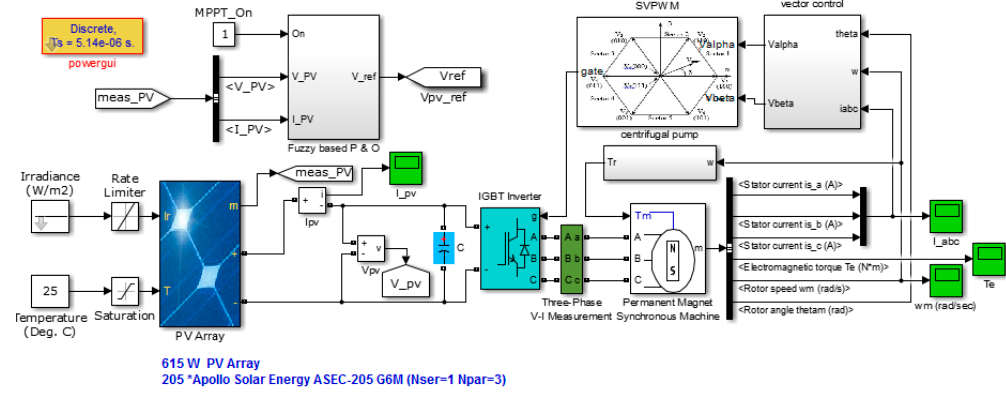
Figure 8. The simulation block diagram of the solar drive systems.